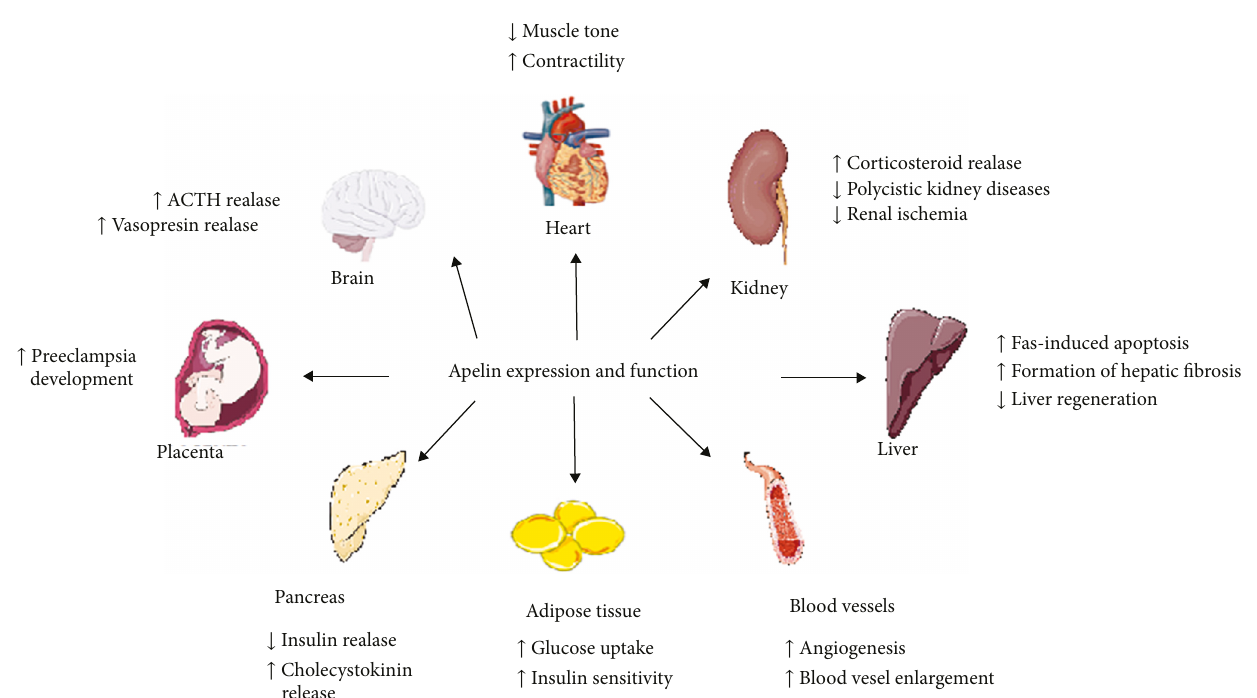
Figure 2: Apelin expression and function in the organism. ACTH: adrenocorticotropic hormone; PRL: prolactin; LH: luteinizing hormone; FSH: follicle-stimulating